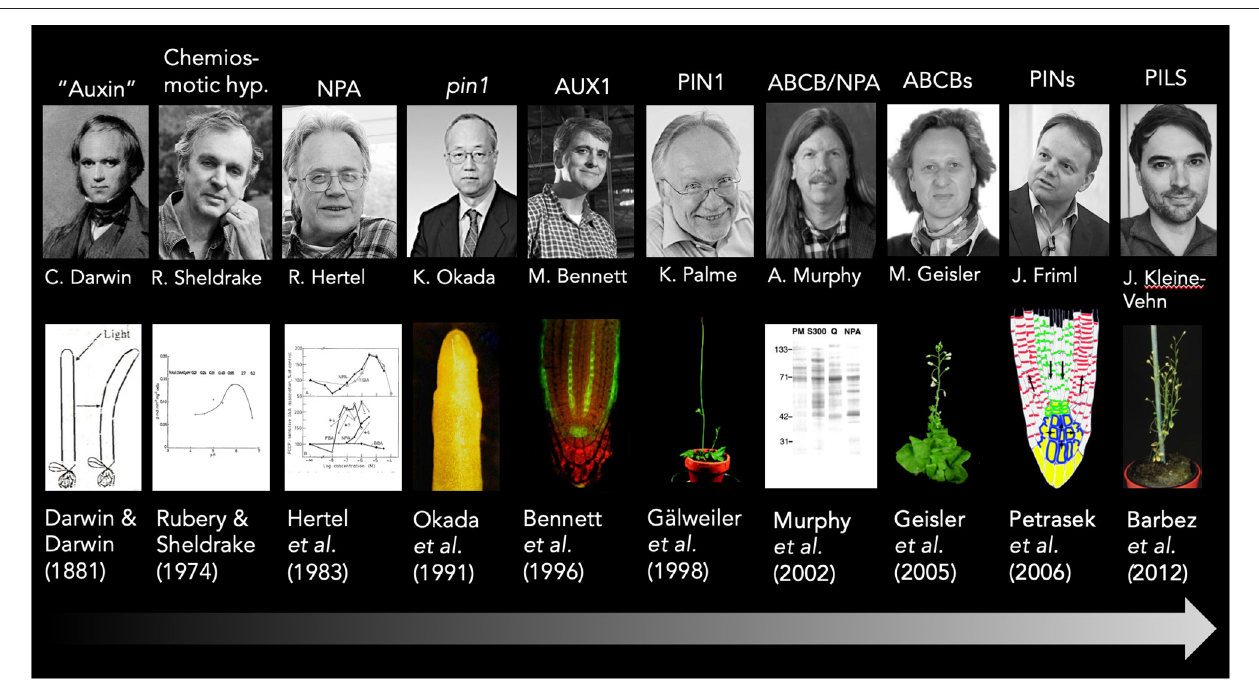
FIGURE 1 | A short timeline of the auxin transport history. Key findings in auxin transport research that are discussed in this article are highlighted and correlated with the main responsible researcher and key publications; exemplary pictures are added for illustration purposes. Please note that due to space restrictions, some topics are only assigned to a single person, and acknowledge that major findings were conducted by several groups. This holds true for the formulation of the chemiosmotic hypothesis that was suggested independently by at least two groups Rubery and Sheldrake (1973), Raven (1975), and summarized later by Goldsmith (1977). Sincere apologies to all colleagues from the auxin transport field that contributed and are not included here. The abcb1 abcb19 mutant picture is taken from Bailly et al. (2006) , while the PIN reflux model is taken from Wabnik et al.